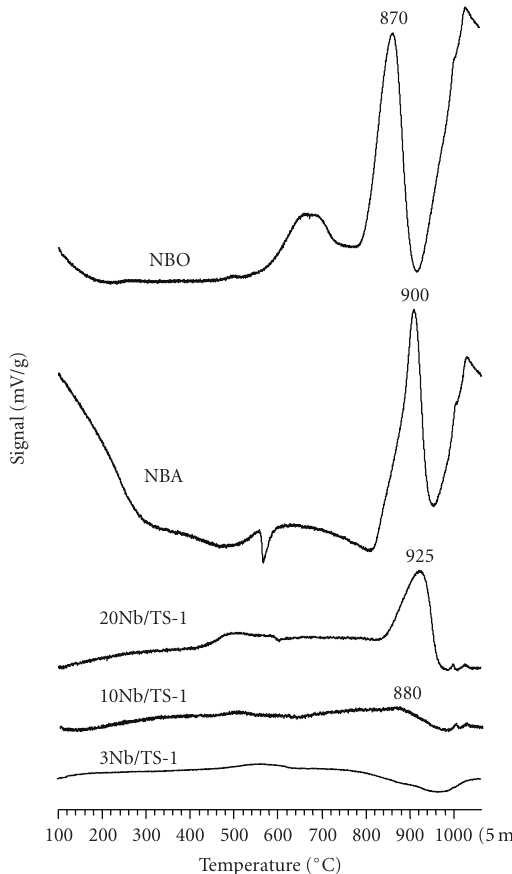
Figure 4: TPR profiles of the NBA, NBO, and X Nb/TS-1 samples.